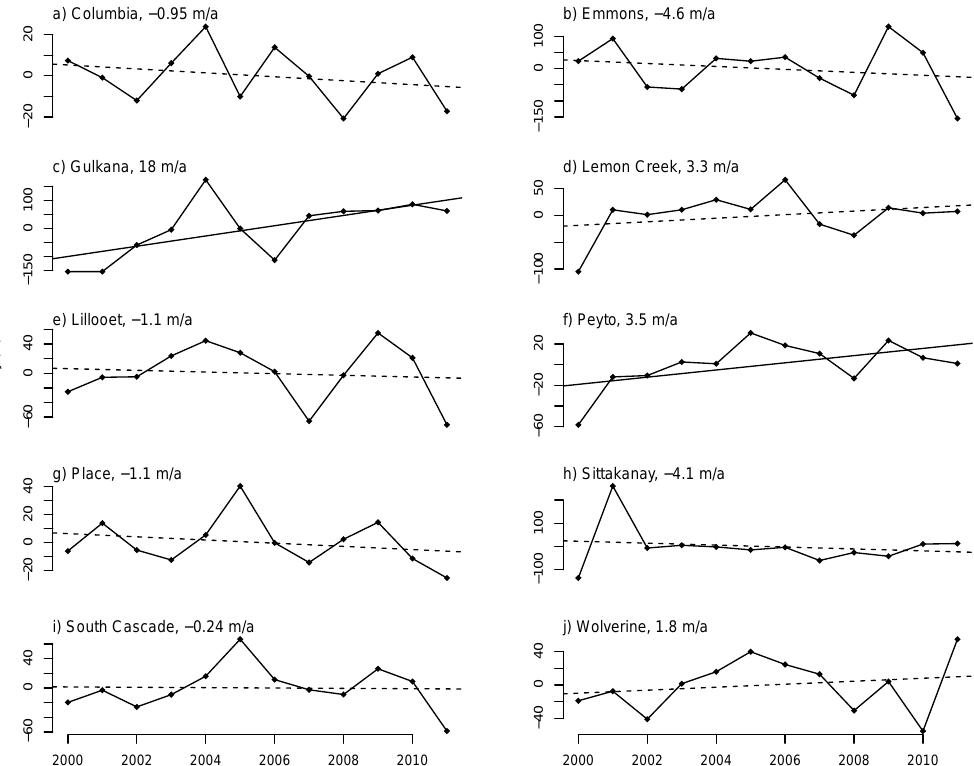
Fig. 11. Time series of regional ELA anomalies derived from MOD02QKM imagery. Least-squares regression fits are shown as dashed lines, trend magnitude (in ma − 1 ) is given in the figure caption, and solid trend lines are significant at p = 0 . 1.